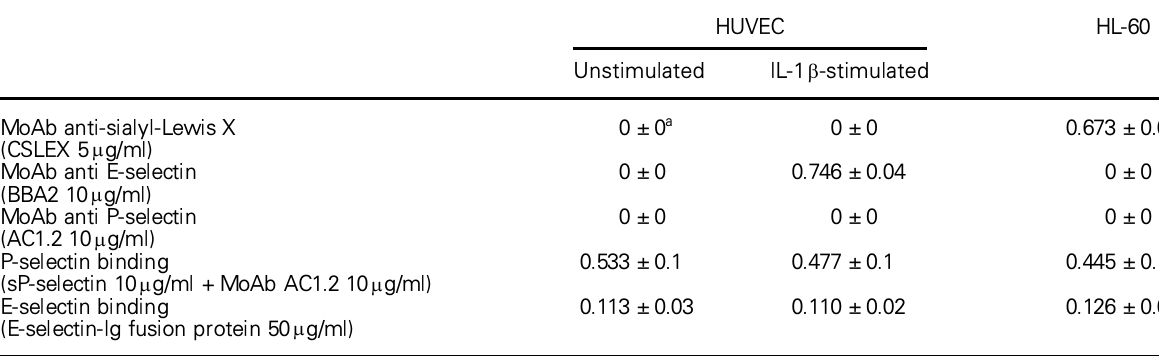
Table 1. Detection of selectins and their cognate ligands on HUVEC and HL-60 cells through cell-ELISA assays